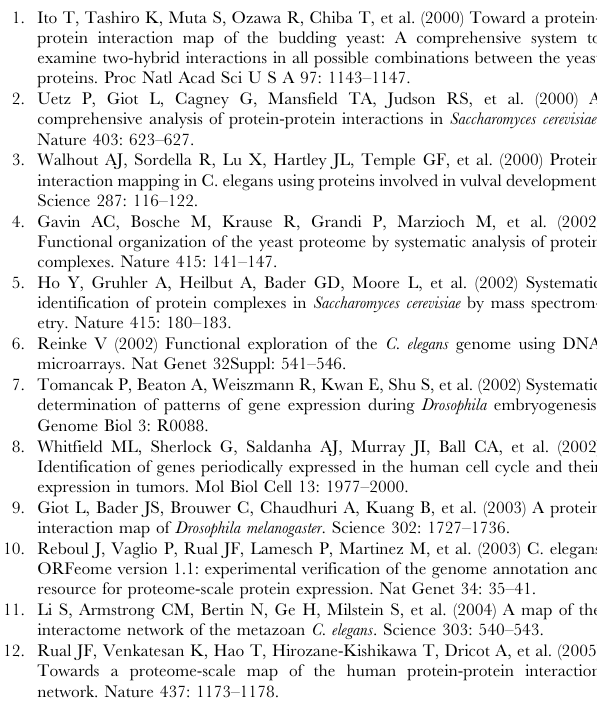
Characteristic curves (A) and Precision-Recall curves (B) for the overall performance and the performance when removing one feature at a time in the KEGG pathway prediction. Precision- Recall curves for the performance of the model in predicting metabolism only (C), signaling pathway only (D), basic functions (E), and all non-metabolism functions (F). Figure S5 Performance of KEGG prediction when limited in the gene space of genetic interaction network. Receiver Operating Characteristic curves (A) and Precision-Recall curves (B) for the overall performance and contribution of each feature in the KEGG pathway prediction. Precision-Recall curves for the performance of the model in predicting metabolism only (C), signaling pathway only (D), basic functions (E), and all non- metabolism functions